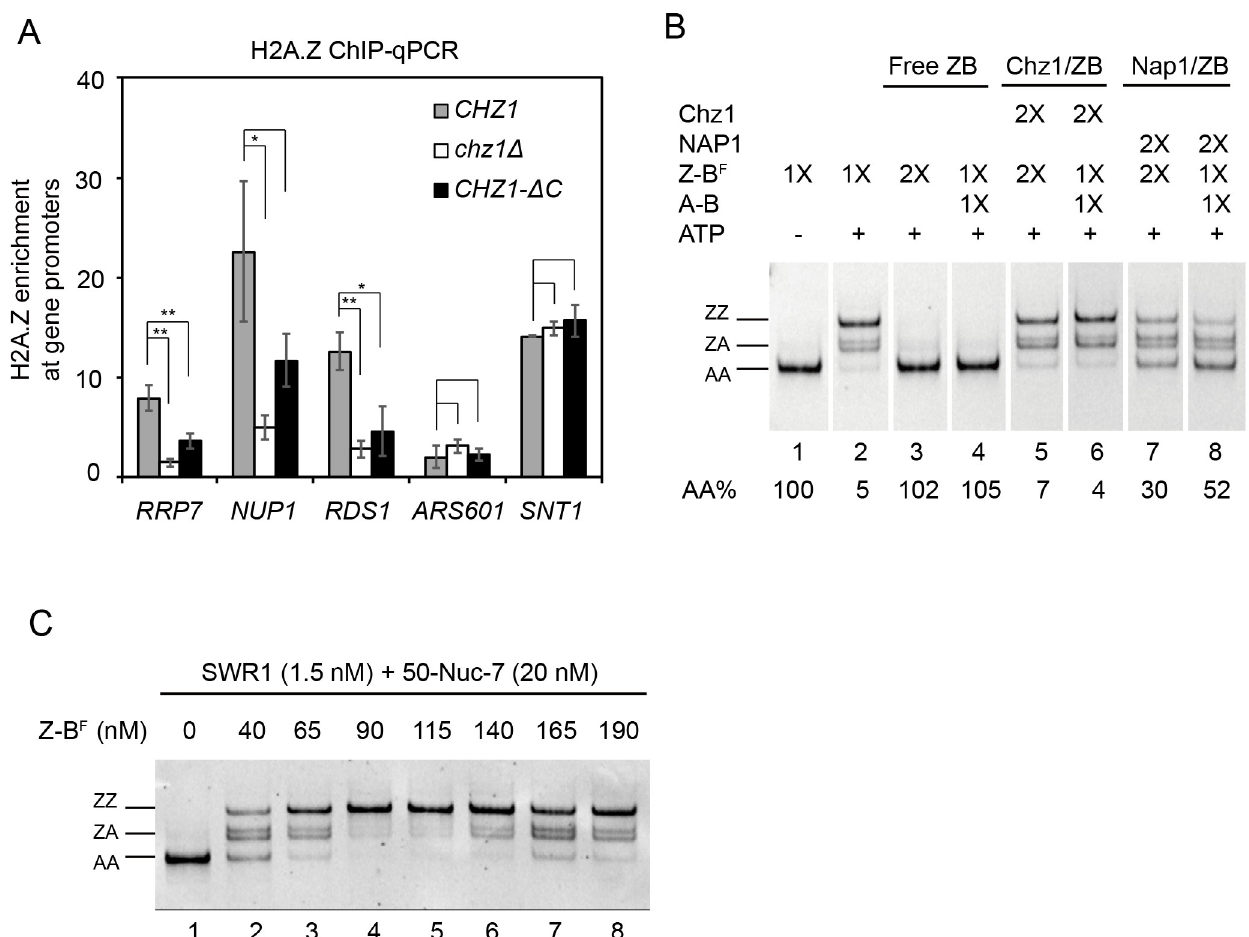
Fig 4. Effect of Chz1 on exchange and chromatin incorporation of H2A.Z. (A) ChIP-qPCR for H2A.Z-HA occupancy at the +1 nucleosome in yeast strains CHZ1 , chz1 Δ , and CHZ1- Δ C . Error bars, SD from 3 technical replicates. �� p < 0.01. � p < 0.05. The underlying data can be found in S3 Data. (B) SWR1-mediated histone exchange in the presence or absence of excess histone dimer and Chz1/Nap1. The initial substrate concentration of H2A.Z-H2B dimer (115 nM) used for regular exchange assay was defined as 1 × . Accordingly, 1 × H2A-H2B dimer, 1 × Chz1, and 1 × Nap1 refer to concentrations in equal molar ratio of H2A.Z-H2B dimer. The order of loading samples is changed for better presentation. Z-B F refers to Z-B dimer in which the H2B contains a FLAG tag. See S6 Fig for original gel. (C) Effect of excess H2A.Z-H2B dimer on H2A.Z exchange. Nucleosome is reconstituted on DNA with 146-bp widom 601 sequence flanking with 50-bp and 7-bp linker DNA at each end. AA, nucleosome containing 2 copies of H2A; Ars601, autonomously replicating sequence 601; ChIP-qPCR, chromatin immunoprecipitation and quantitative PCR; Chz1, chaperone for H2A.Z-H2B; Nap1, Nucleosome assembly protein 1; Nup1, nuclear Pore 1; Rds1, regulator of drug sensitivity 1; Rrp7, ribosomal RNA processing 7; Snt1, SANT 1; ZA, nucleosome containing 1 copy of H2A and H2A.Z each; ZZ, nucleosome containing 2 copies of